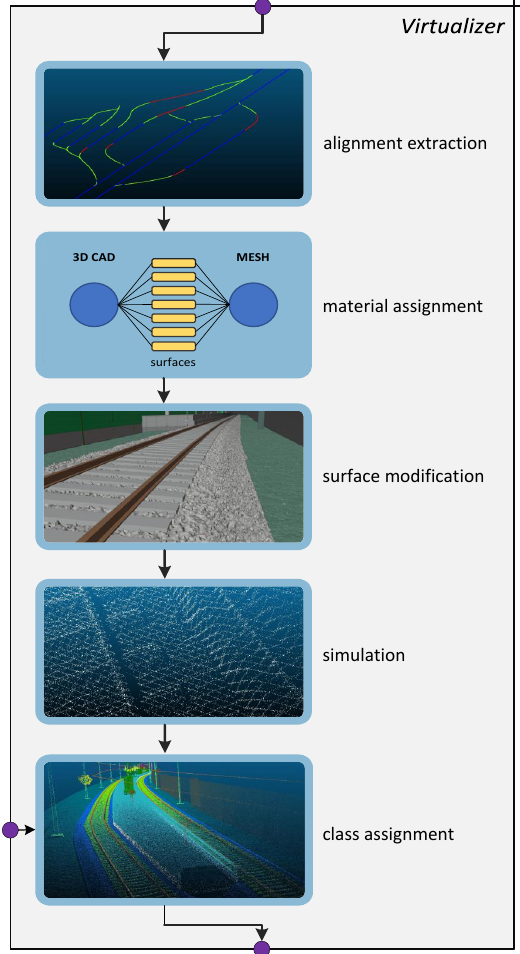
Figure 2. Conceptual overview of the Virtualizer. Based on the alignment definitions of the CAD files, a virtual rail cart will convert the models into suitable point clouds. Prior to the simulation with helios++, materials and surfaces are updated. In the last step, the classes are assigned to the points based on the new project